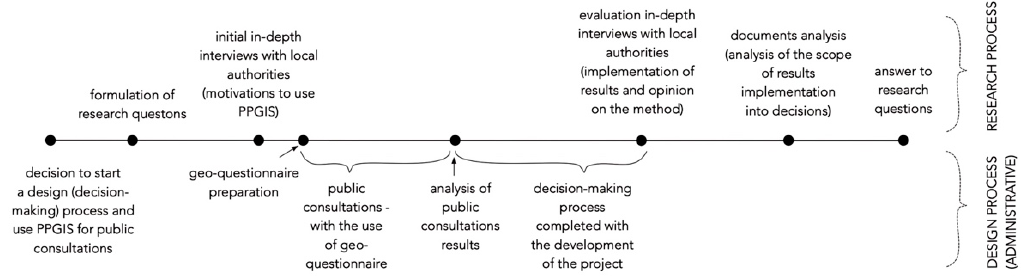
Figure 2. Research process and the administrative design process. Source: own elaboration.